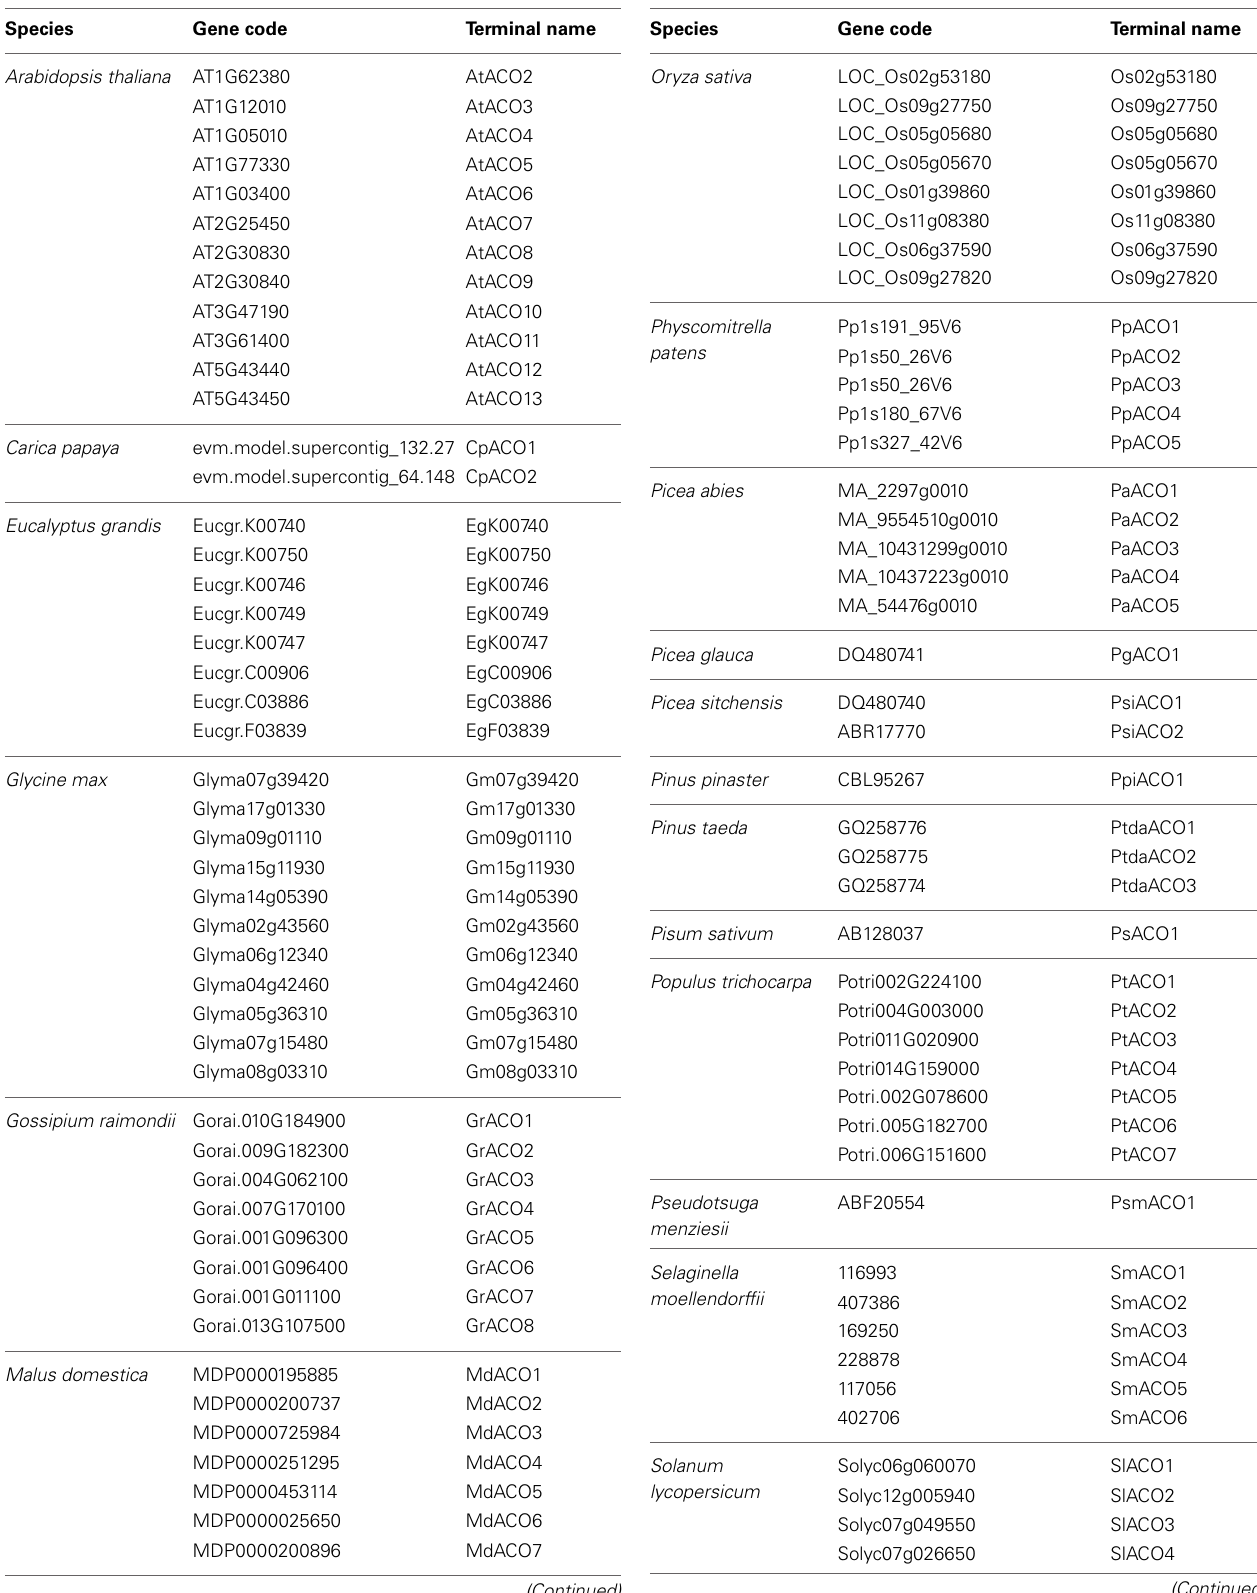
Table 2 | ACO genes analyzed in this